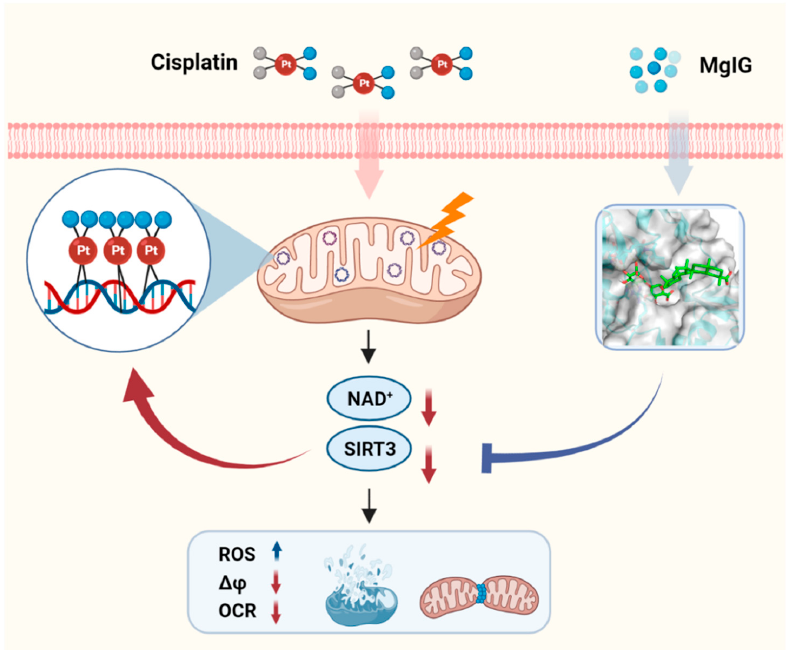
Figure 7. Schematic depicting the role of MgIG in cisplatin-induced kidney injury. Cisplatin tends to accumulate in the mitochondria of renal tubular epithelial cells and binds to mtDNA, causing a decrease in NAD+ and SIRT3, resulting in mitochondrial dysfunction and cytotoxicity. MgIG can bind to SIRT3 and reduce the target-binding amount of cisplatin to mtDNA, thus exerting a protective effect on cisplatin-induced renal injury through SIRT3.